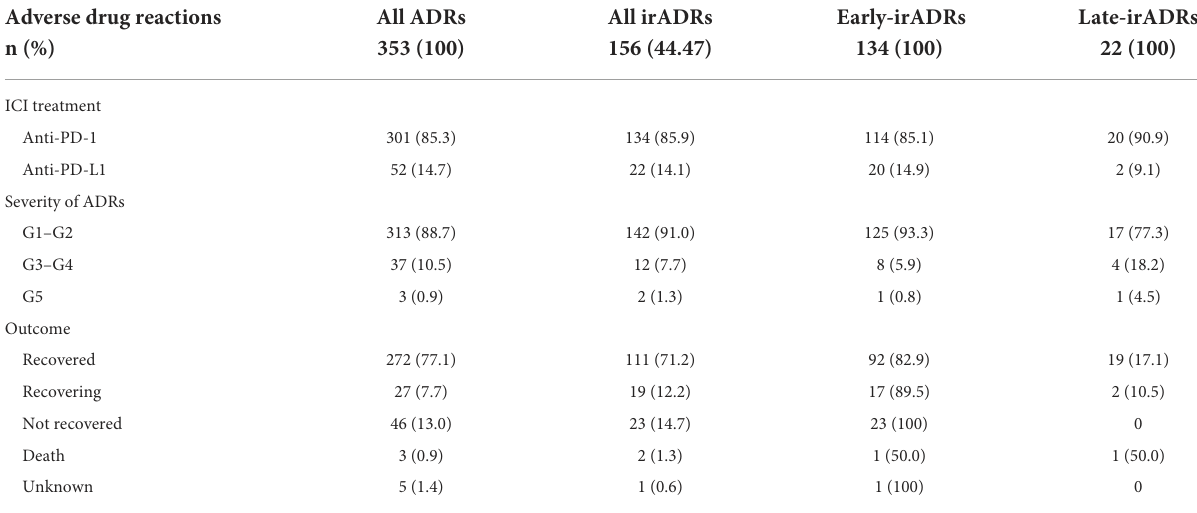
TABLE 4 Adverse drug reactions, severity, and outcome. Adverse drug